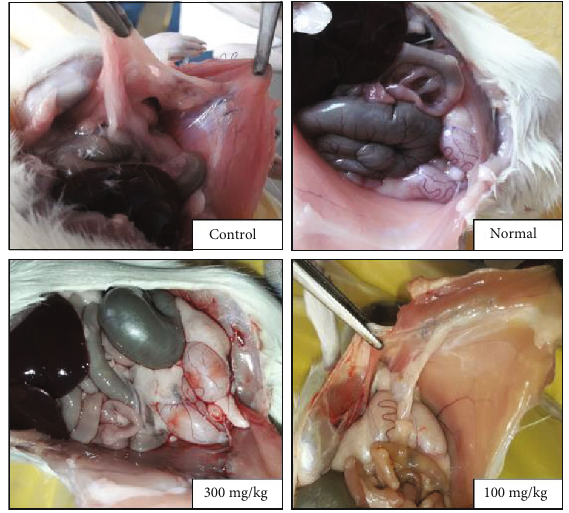
Figure 2: Macroscopic evaluation of PA bands in normal, control, and PO at doses of 100 and 300 mg/kg